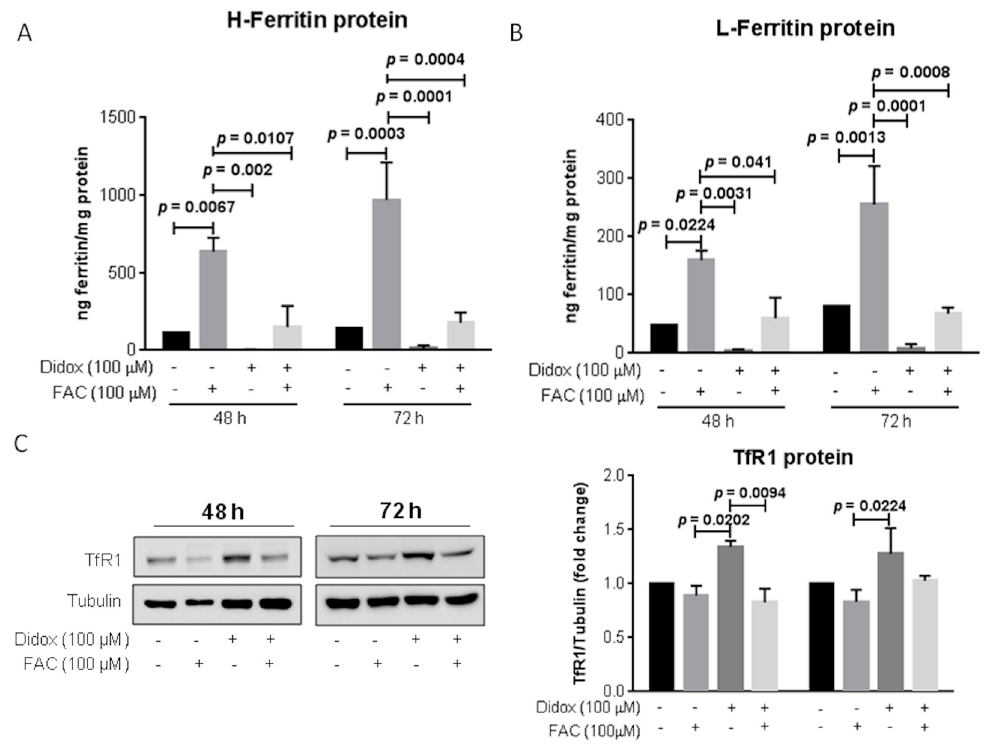
Figure 8. Treatment with equimolar concentration of iron restored iron-related protein content. HA22T / VGH cells were untreated or treated with: 100 µ M didox alone or in combination with FAC (100 µ M) for 48 and 72 h. Protein extracts were analyzed for H- and L-ferritin content ( A , B ) by an ELISA assay and for TfR1 by western blotting ( C ), using tubulin as a loading control. The graphs are the mean of three independent experiments ( N = 3). p -values, showed in the graphs, were obtained by an ordinary one-way ANOVA.